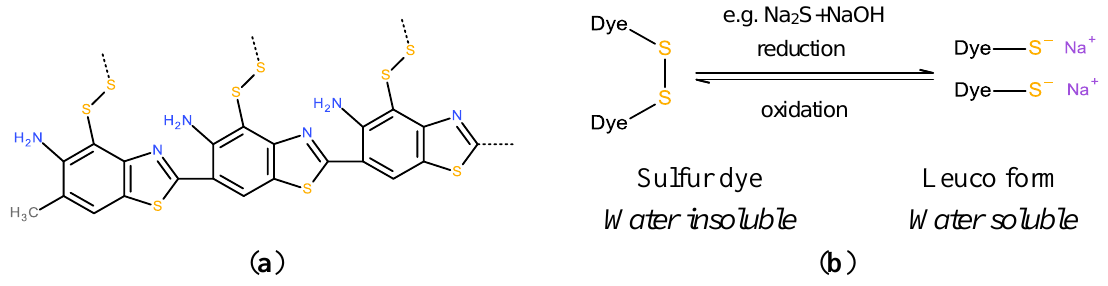
Figure 3. ( a ) an example of a sulfur dye [37]; ( b ) The intensely colored and